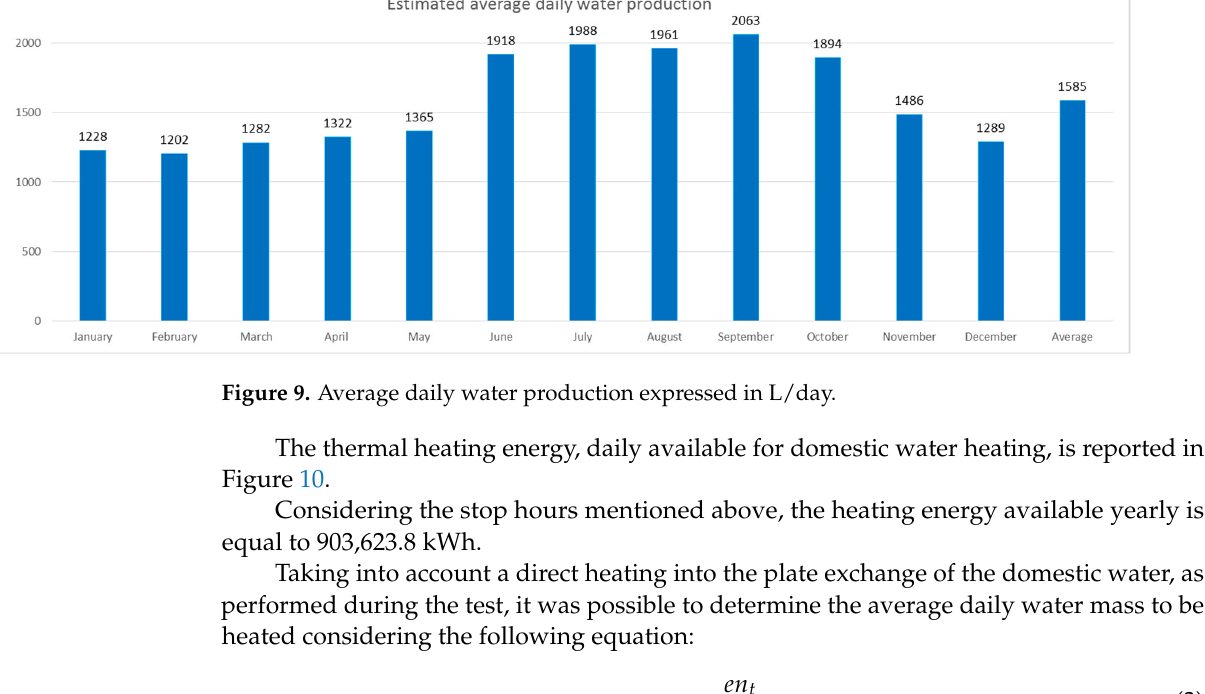
Figure 9. Average daily water production expressed in L/day.